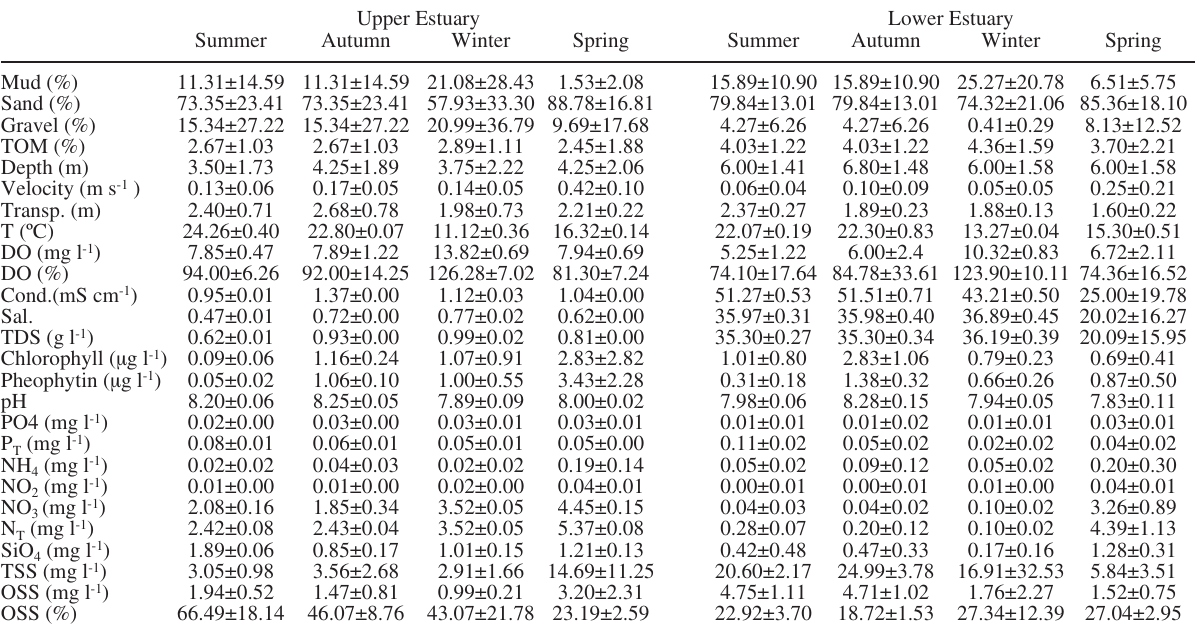
Table 1. – Sediment characteristics and water physicochemical parameters (seasonal mean±standard deviation, n=4) in the two different stretches. TOM, total organic matter in sediment; Transp., transparency; DO, dissolved oxygen; Cond., conductivity; Sal., salinity; TDS, total dissolved salts; TSS, total suspended solids; OSS, organic suspended